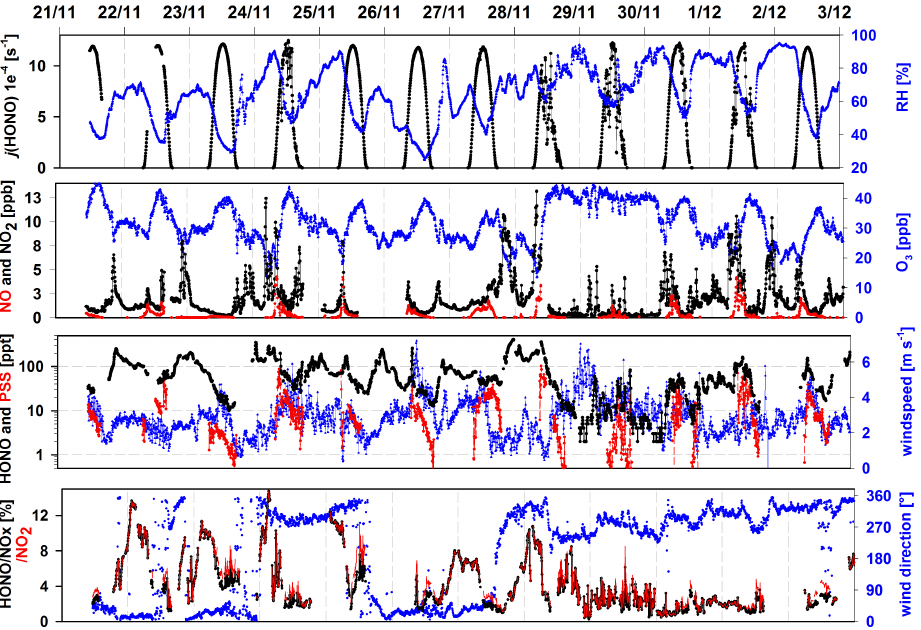
Fig. 1. Overview of meteorological (RH, wind speed and wind direction) and chemical quantities (O 3 , NO, NO 2 , HONO, HONO PSS (calculated), HONO/NO x and HONO/NO 2 ratios and j (HONO)). Helsinki, Finnland) meteorological station on top of the MoLa ( Mo bile La boratory) inlet system, which was at 10 m height 10 m southeast of the scaffold. For details see Diesch et al.